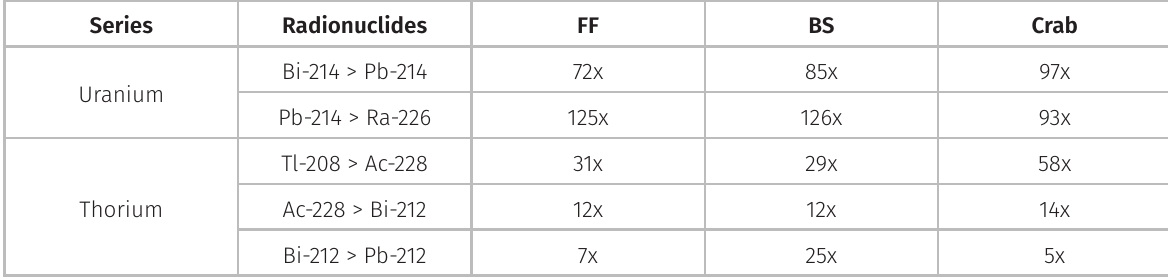
Table III. Comparison between the D